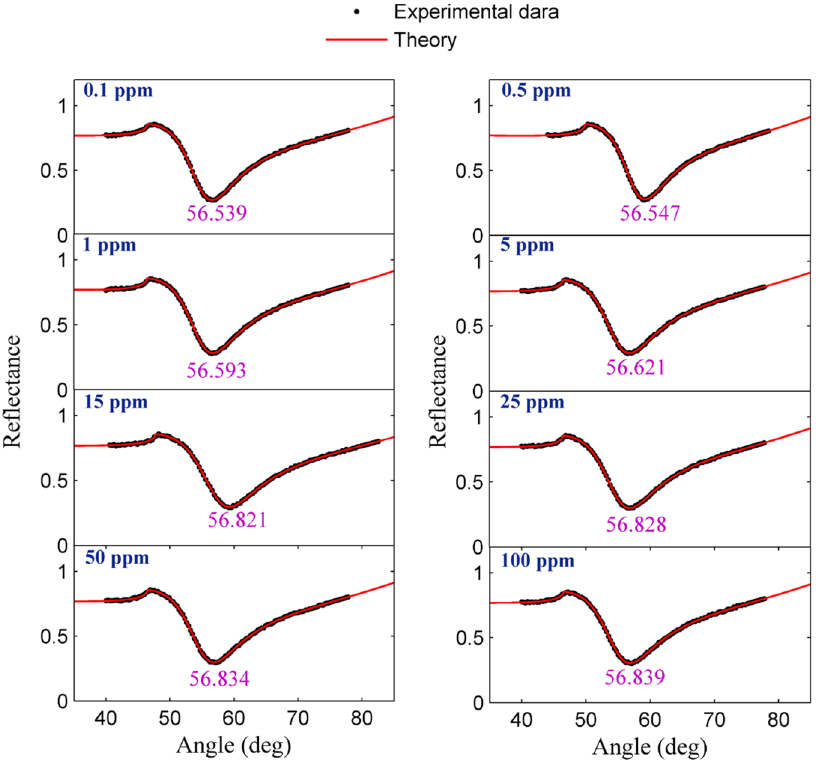
Figure 8. SPR signals related to determining the concentration of Fe ion in an aqueous solution at the saturation value.